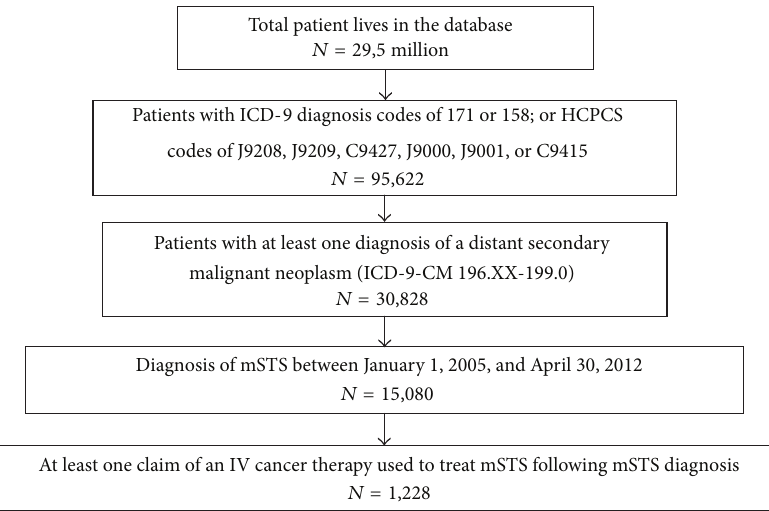
Figure 1: Sample